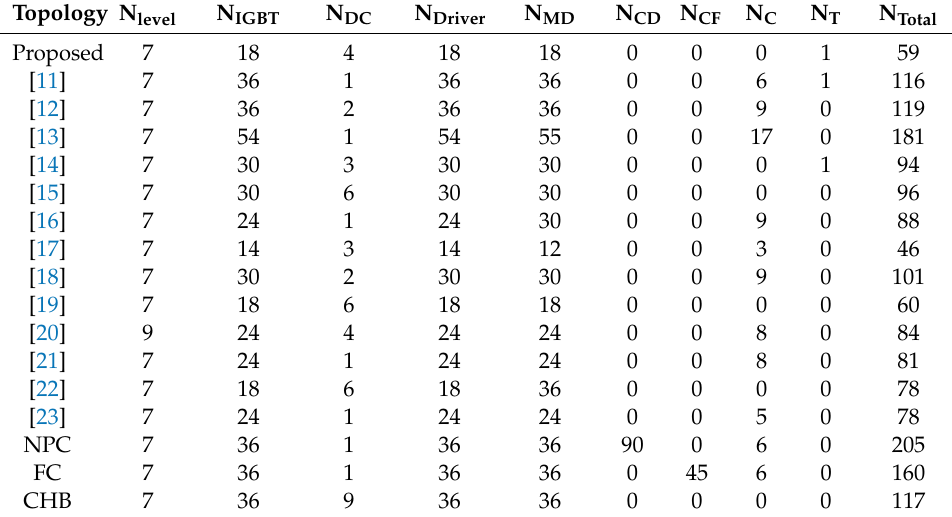
Table 2. Comparative analysis of proposed topology and other presented topologies.